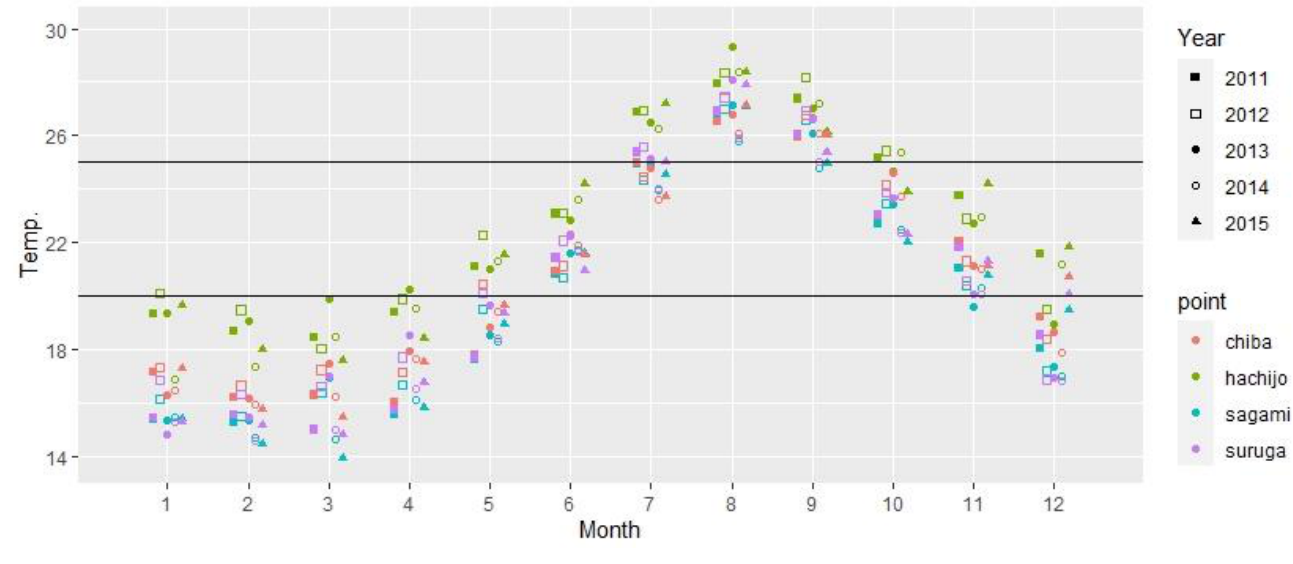
Figure 2. Changes in water temperature from 2011 to 2015.